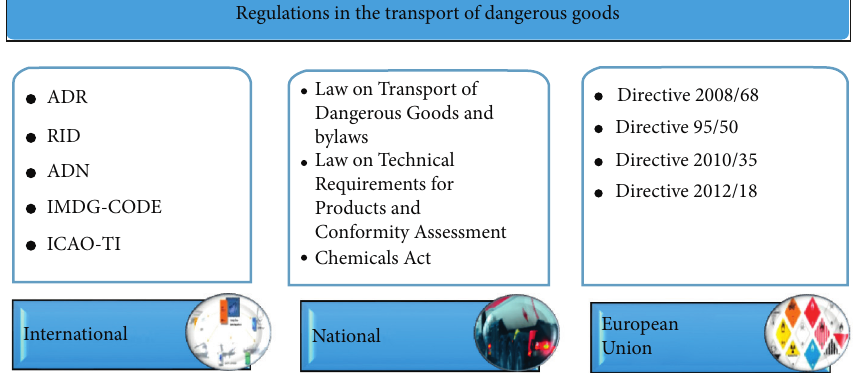
Figure 1: Legal acts on the transport of dangerous goods.